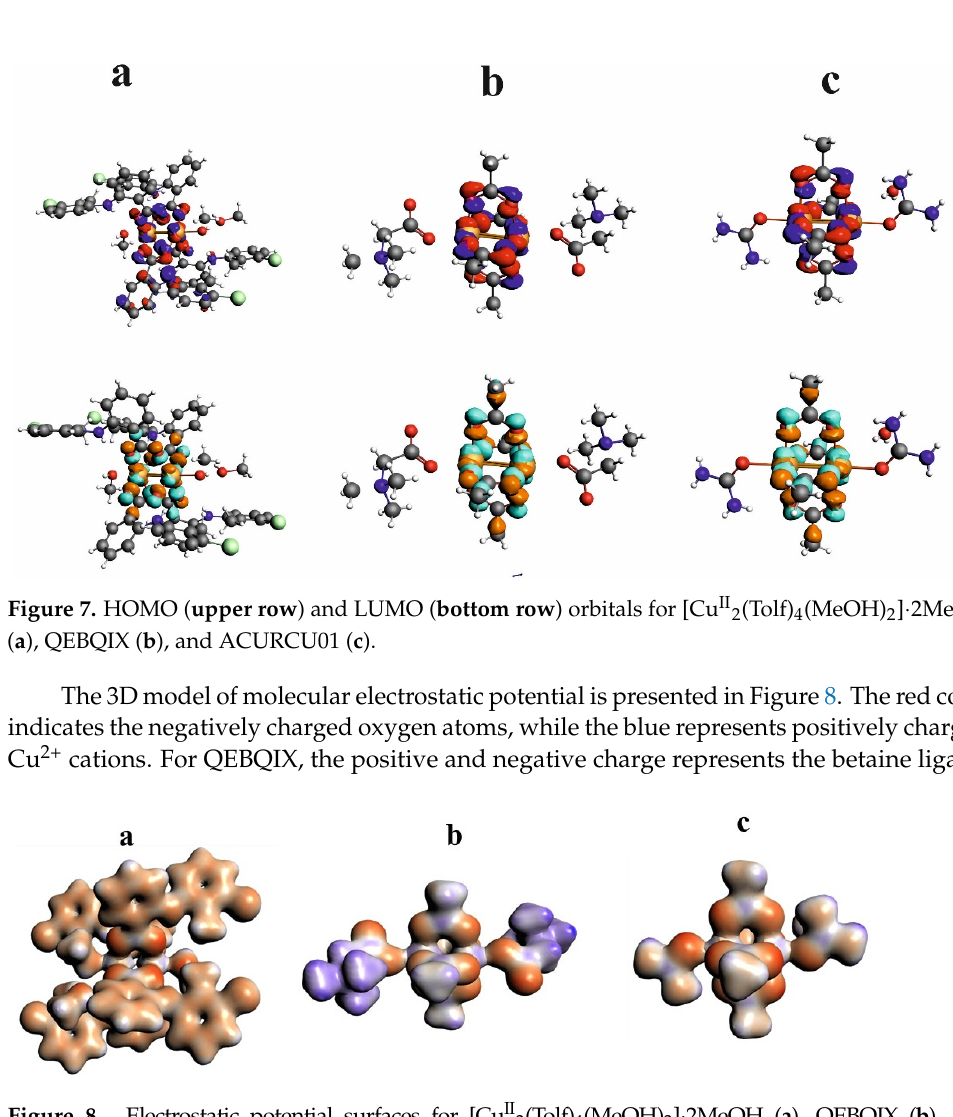
Figure 8. Electrostatic potential surfaces for [Cu II2 (Tolf) 4 (MeOH) 2 ] ∙ 2MeOH ( a ), QEBQIX ( b ), and ACURCU01 ( c ). Field isosurfaces have been generated at the value of 0.03. Red—negative, blue—positive.